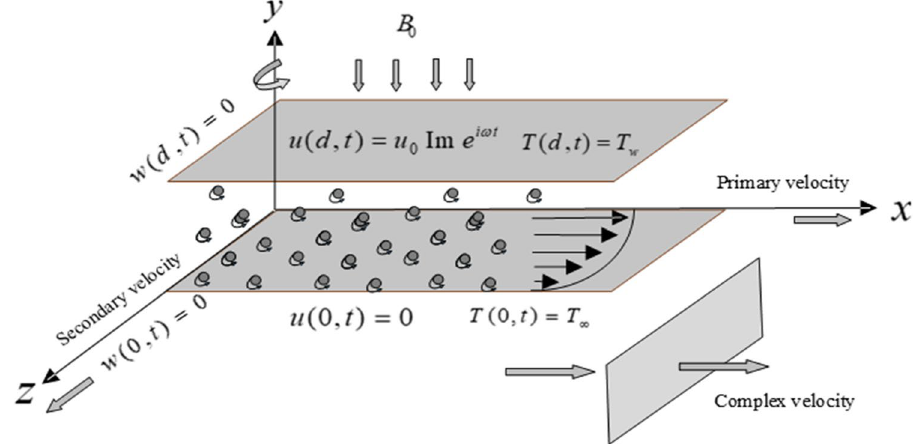
Figure 1. Schematic diagram of the